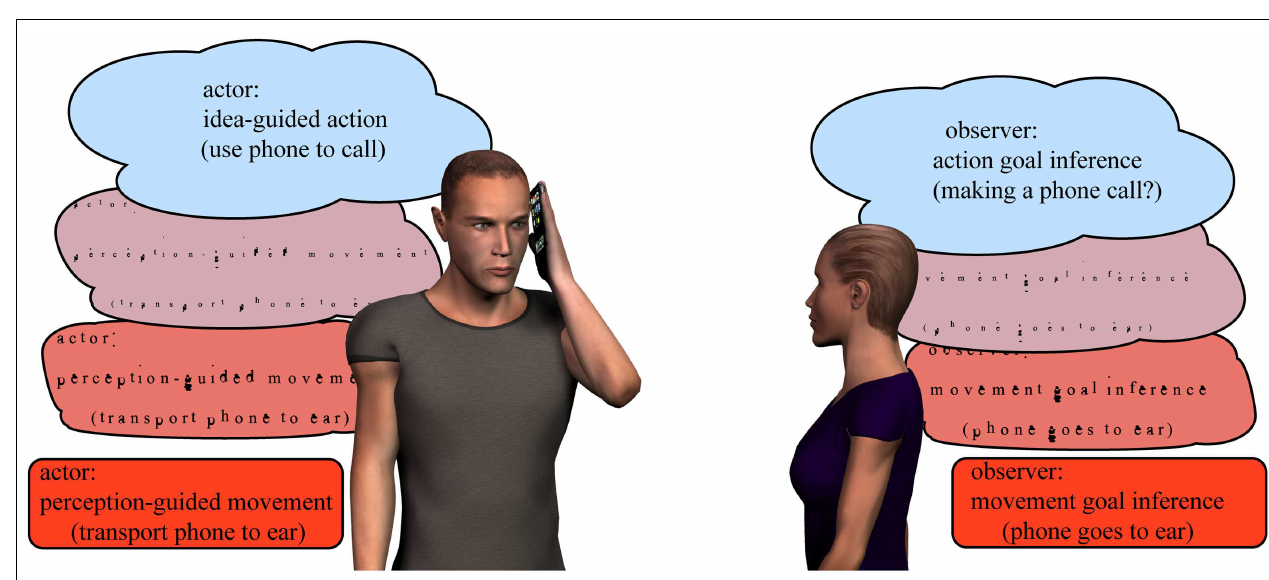
infer both aspects as well. First, is the actor going to make a phone call?This conceptual goal inference depends on recruiting the conceptual knowledge regarding the function of the object. Second, is the actor bringing the phone to the ear?This movement goal inference depends on the concrete perceptuo-motor associations that link phone to the